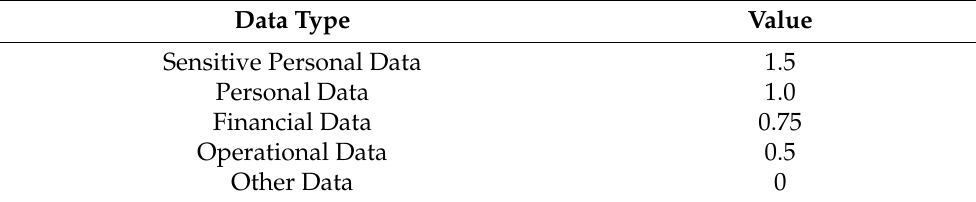
Table 4. Data Type values.